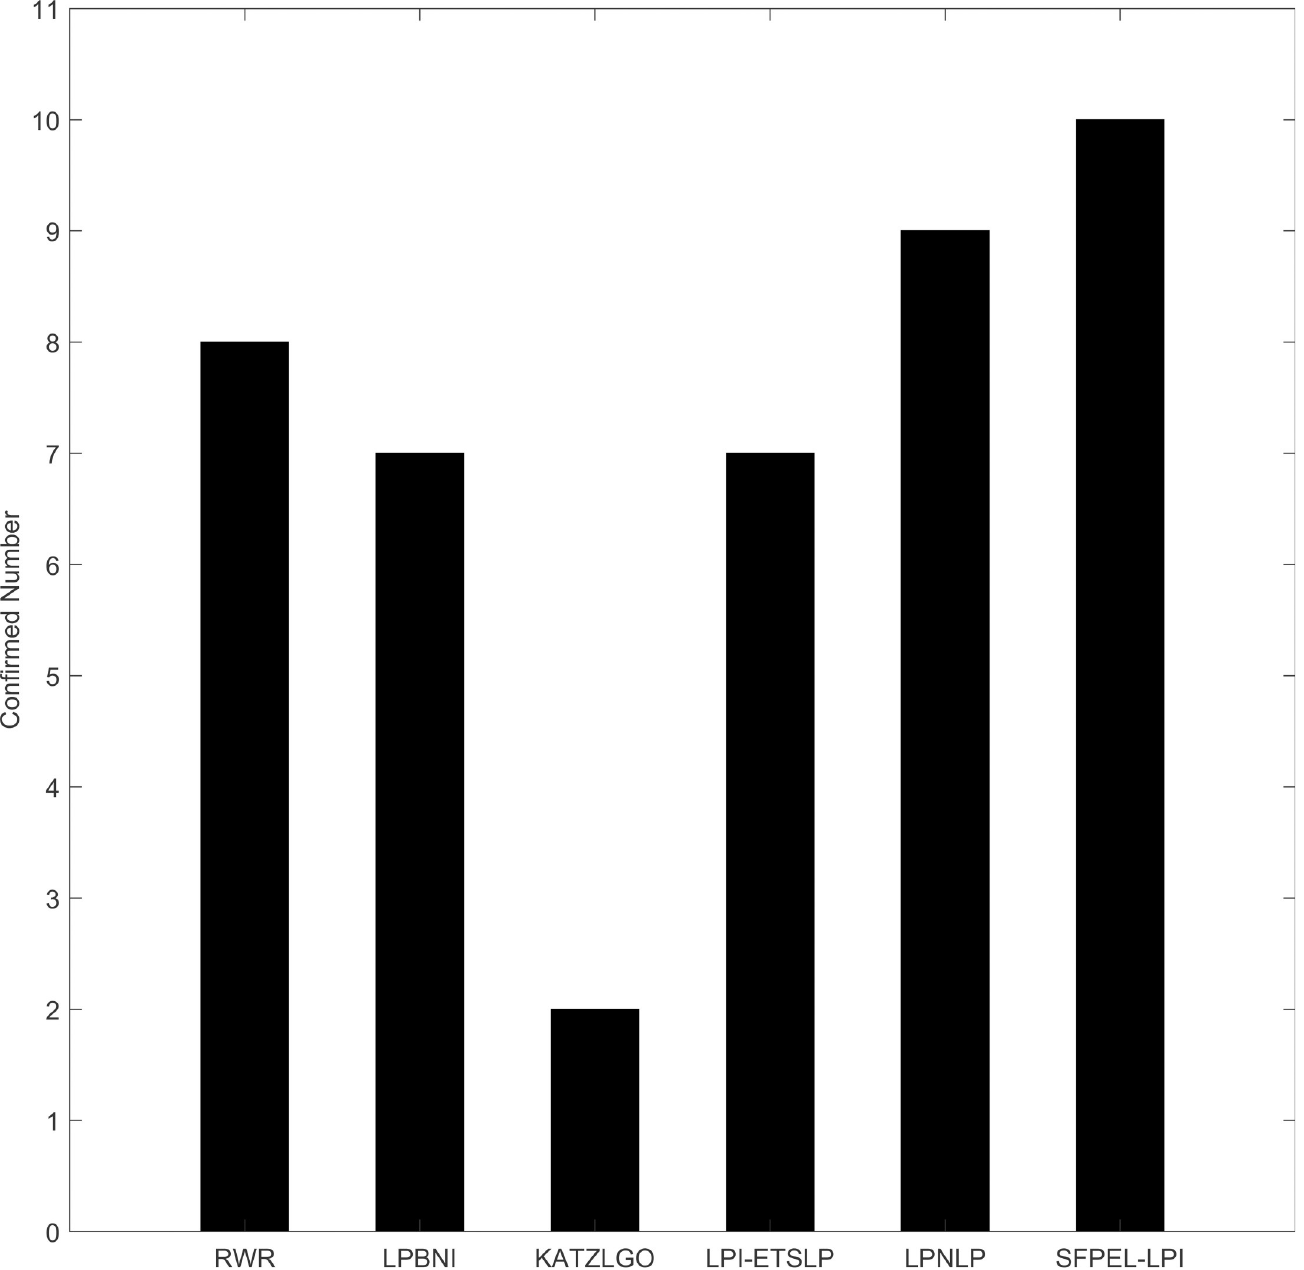
Fig 6. The number of confirmed lncRNA-protein interactions in top 20 predictions of different methods. https://doi.org/10.1371/journal.pcbi.1006616.g006 PLOS Computational Biology | https://doi.org/10.1371/journal.pcbi.1006616 December 11,